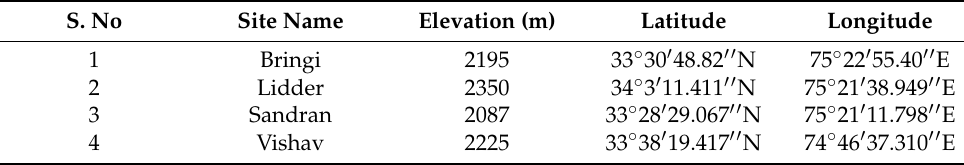
Table 5. Geo-coordinates of proposed dam